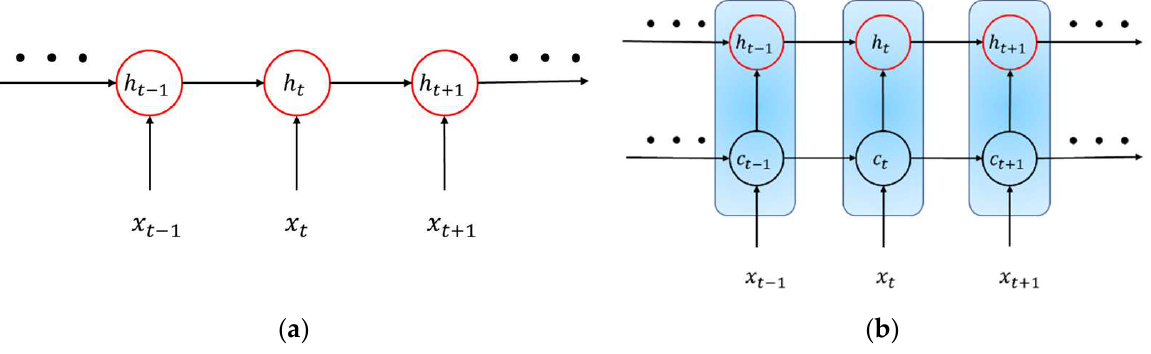
Figure 5. Architecture of RNN. ( a ) Normal architecture of RNN. ( b ) LSTM network.